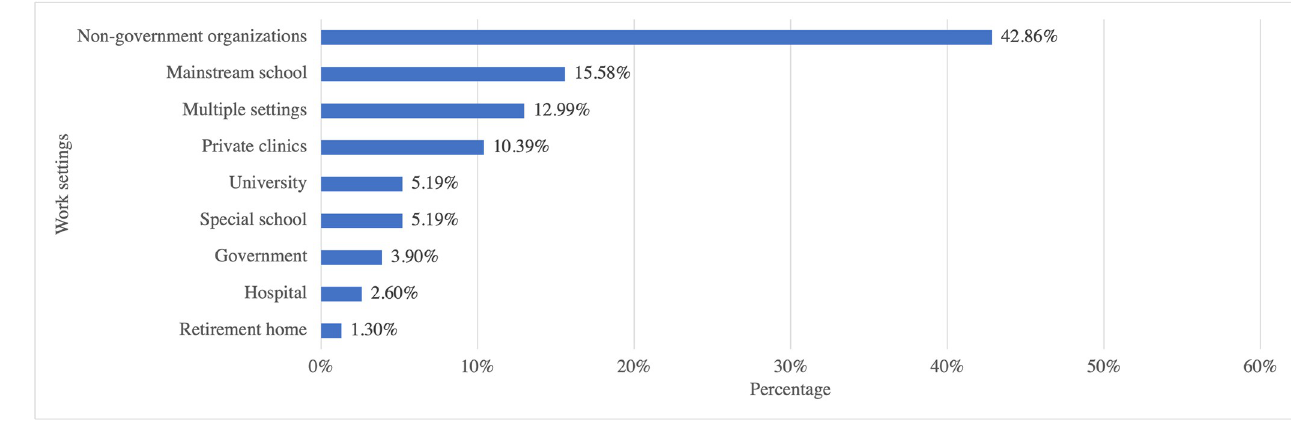
Fig 1. Distribution of respondents’ work settings.